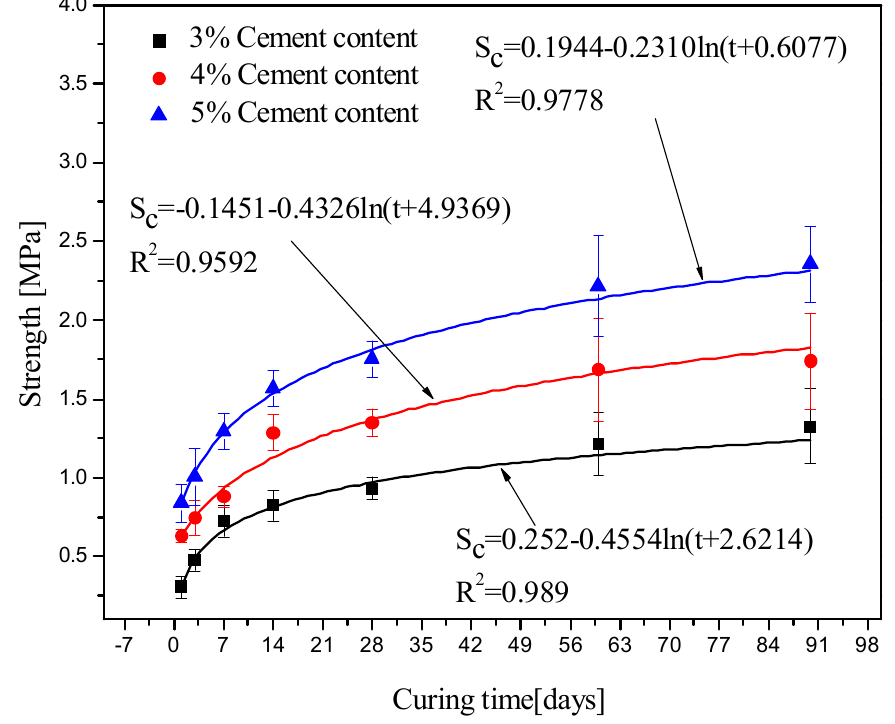
Figure 3. Variation patterns of the indirect tensile strength with the curing time and cement content.